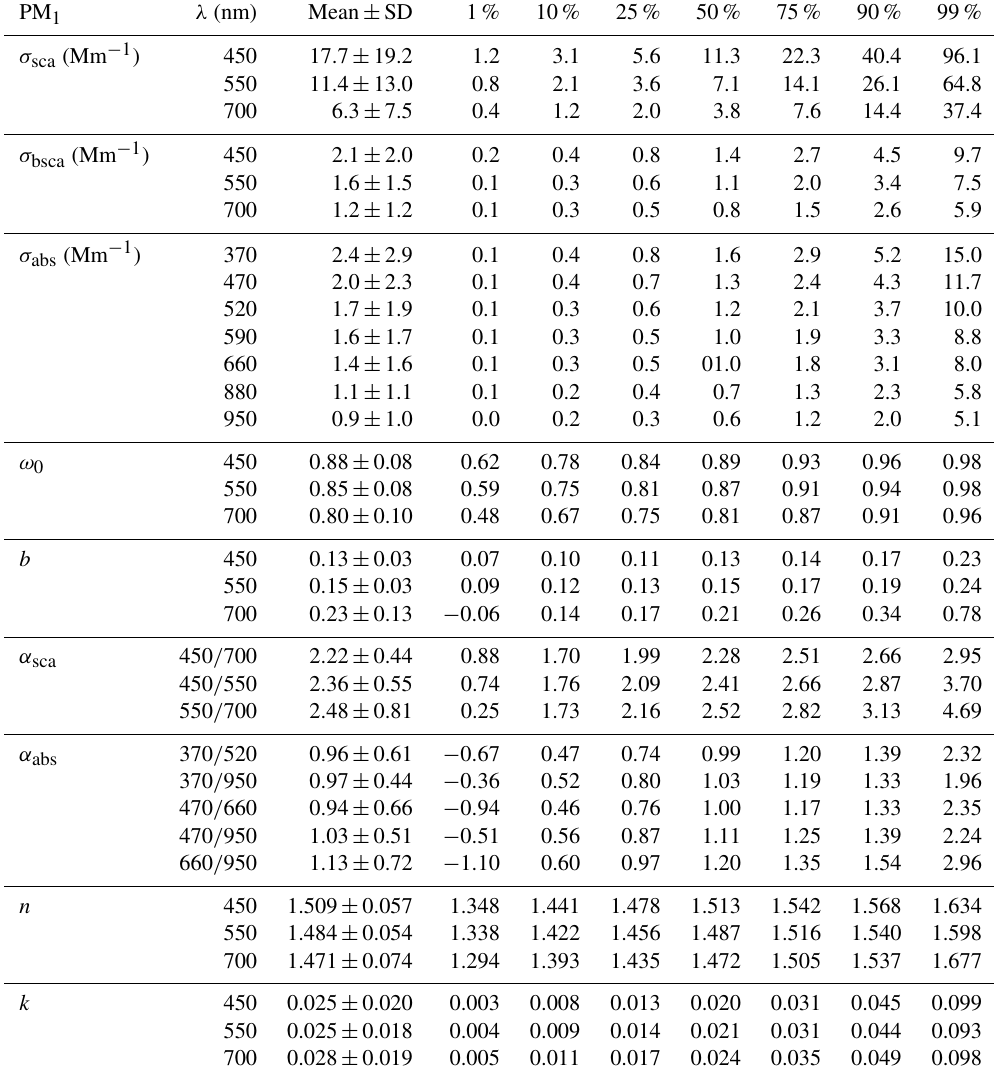
Table 2. Descriptive statistics of the AOPs for the PM 1 particles. The average values were calculated from all valid data; therefore if compared with the PM 10 average values, there is a 4-year-shorter data